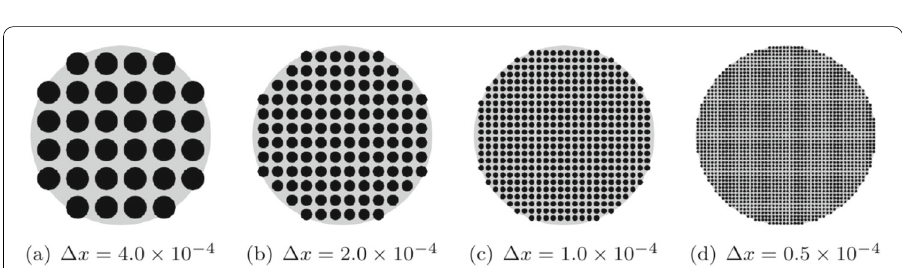
Fig. 6 Spatial discretization of a rigid circular disk: resulting spatial discretization of a rigid circular disk with rigid particles for selected values of the initial particle spacing (cid:10) x